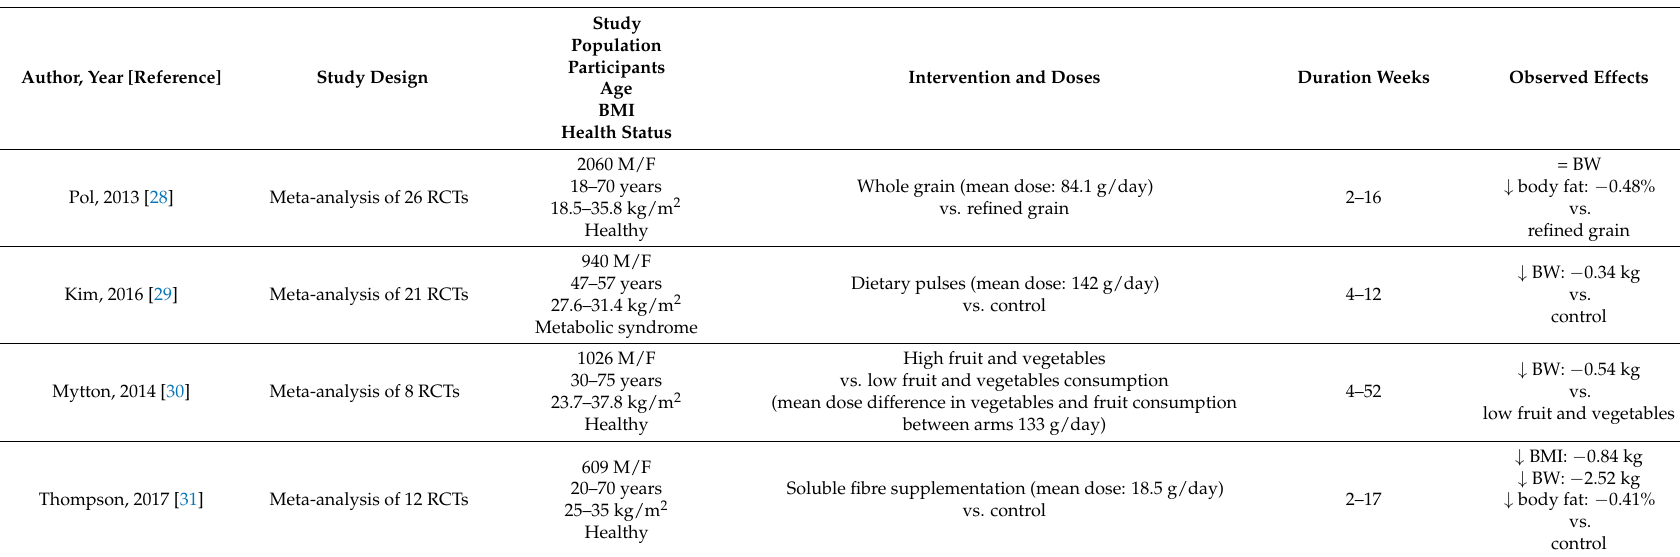
Table 2. Published meta-analyses of RCTs evaluating the effects of different types of fibre on body weight